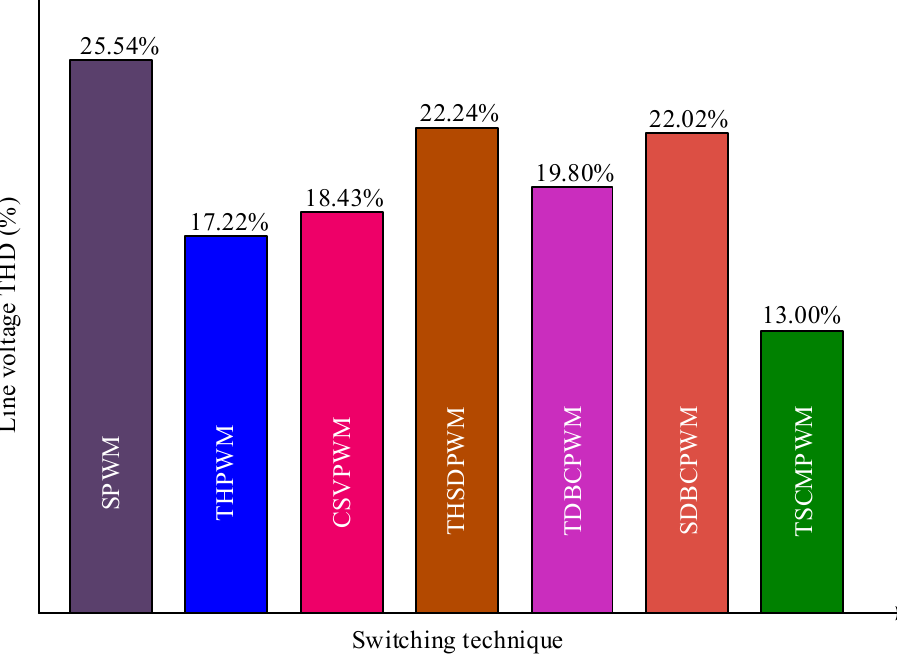
Figure 10. Comparisons of the MMC inverter line voltage THDs for the existing and the proposed TSCMPWM techniques.